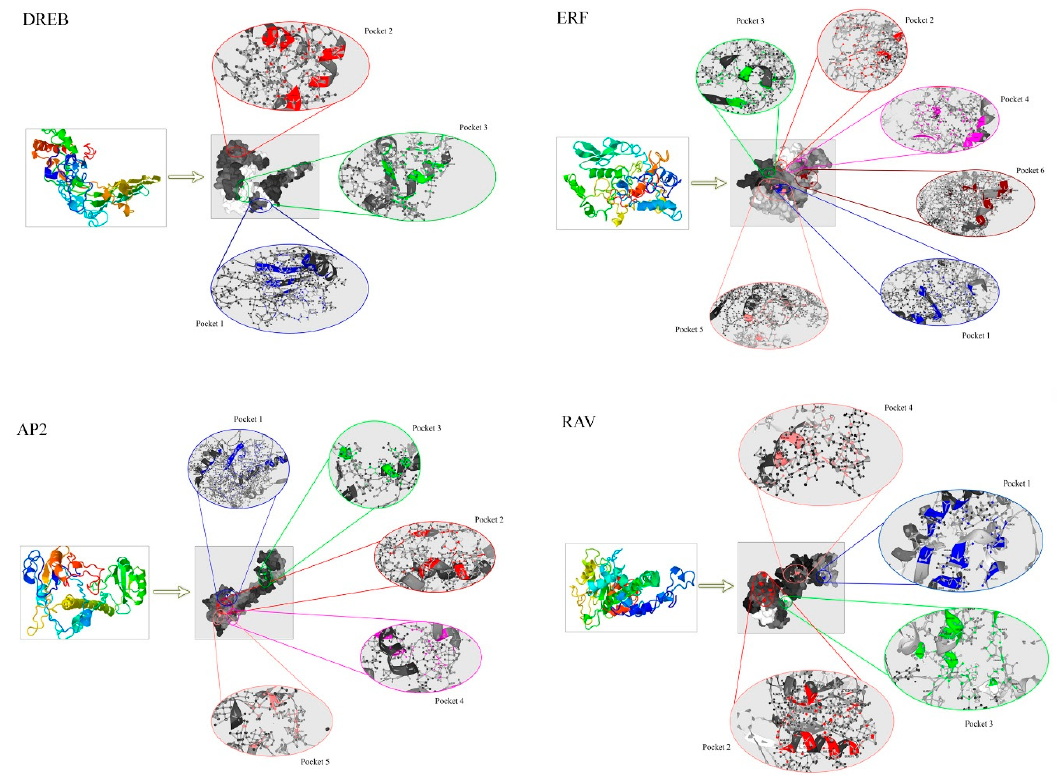
Figure 6. Predicted 3D structure of candidate TtAP2 / ERF proteins in durum wheat. Docking analysis of the major protein pocket sites was also performed before each 3D model was constructed.